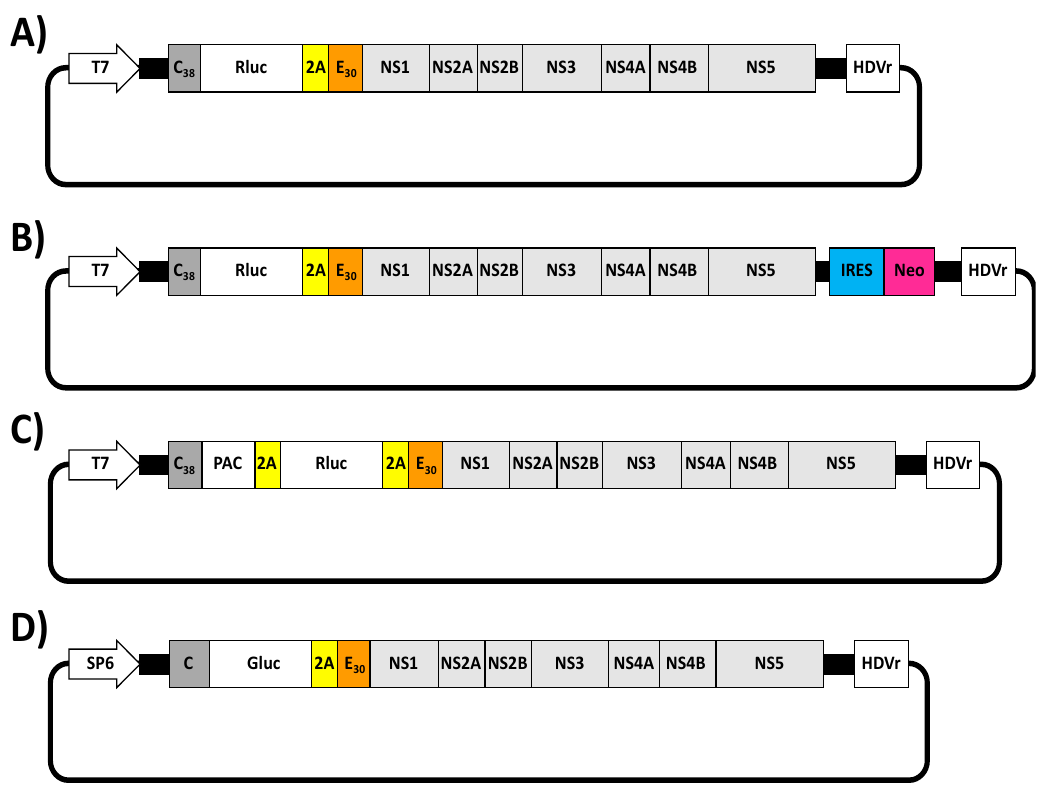
Figure 4. ZIKV replicons. ( A , B ) Schematic diagram of Rluc-expressing ZIKV replicons: ZIKV replicons expressing Rluc constructed by Xie et al. [101] are shown. In these replicons, ZIKV structural proteins were replaced by the Rluc reporter gene followed by the FMDV 2A protease sequence (2A, yellow). This cassette was flanking by the N-terminal 38 amino acids of C protein (C 38 , dark gray) and the last 30 amino acids of E protein (E 30 , orange) fused in-frame with the viral downstream NS proteins ( A ). A stable reporter ZIKV Rluc-expressing replicon was constructed inserting the encephalomyocarditis virus internal ribosomal site (IRES, blue) followed by a neomycin resistance gene (Neo, pink) into the first 28 nucleotides of 3 ′ UTR ( B ). ( C ) Schematic representation of a PAC- and Rluc-expressing ZIKV replicon: The ZIKV replicon expressing a PAC and a Rluc genes separated by the FMDV 2A protease sequence is shown [105]. Both foreign viral genes, PAC and Rluc, followed by the FMDV 2A protease sequence were introduced between of the first N-terminal 38 amino acids of C protein (C 38 , dark gray) and the last 30 amino acids of E protein (E 30 , orange) in-frame with the viral NS1 protein. ( D ) Schematic diagram of a Gluc-expressing ZIKV replicon: The ZIKV replicon expressing the Gluc reporter gene constructed by Mutso et al. is indicated [48]. The Gluc reporter gene followed by the FMDV 2A protease sequence was introduced downstream of the C protein (dark gray) and the last N-terminal 30 amino acids of E protein (E 30 , orange) fused in-frame with the NS1 ZIKV protein. T7 and SP6: prokaryotic T7 or SP6 promoters. HDVr: Hepatitis delta virus ribozyme sequence.